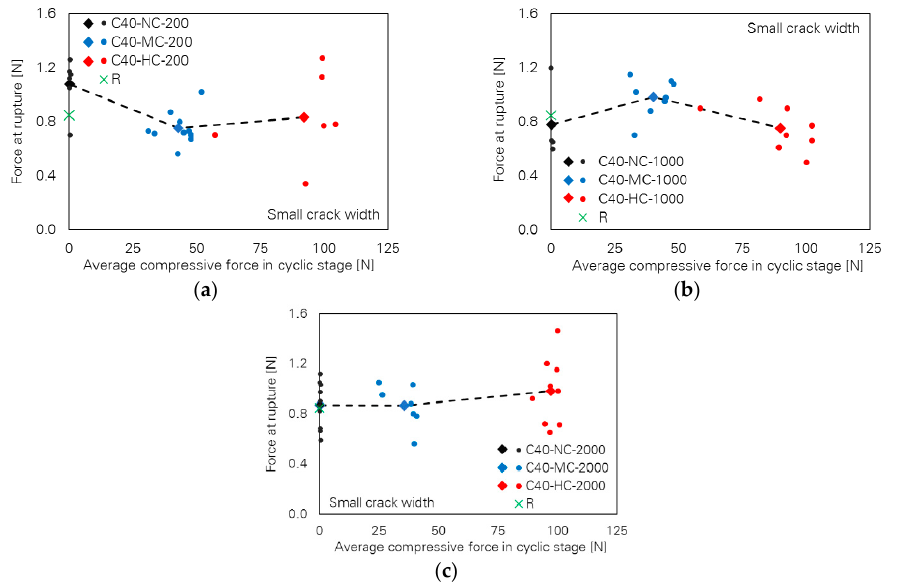
Figure 4. Influence of cyclic compressive force level on force at rupture of the specimens with small crack width; number of cycles: ( a ) 200, ( b ) 1000 and ( c ) 2000.